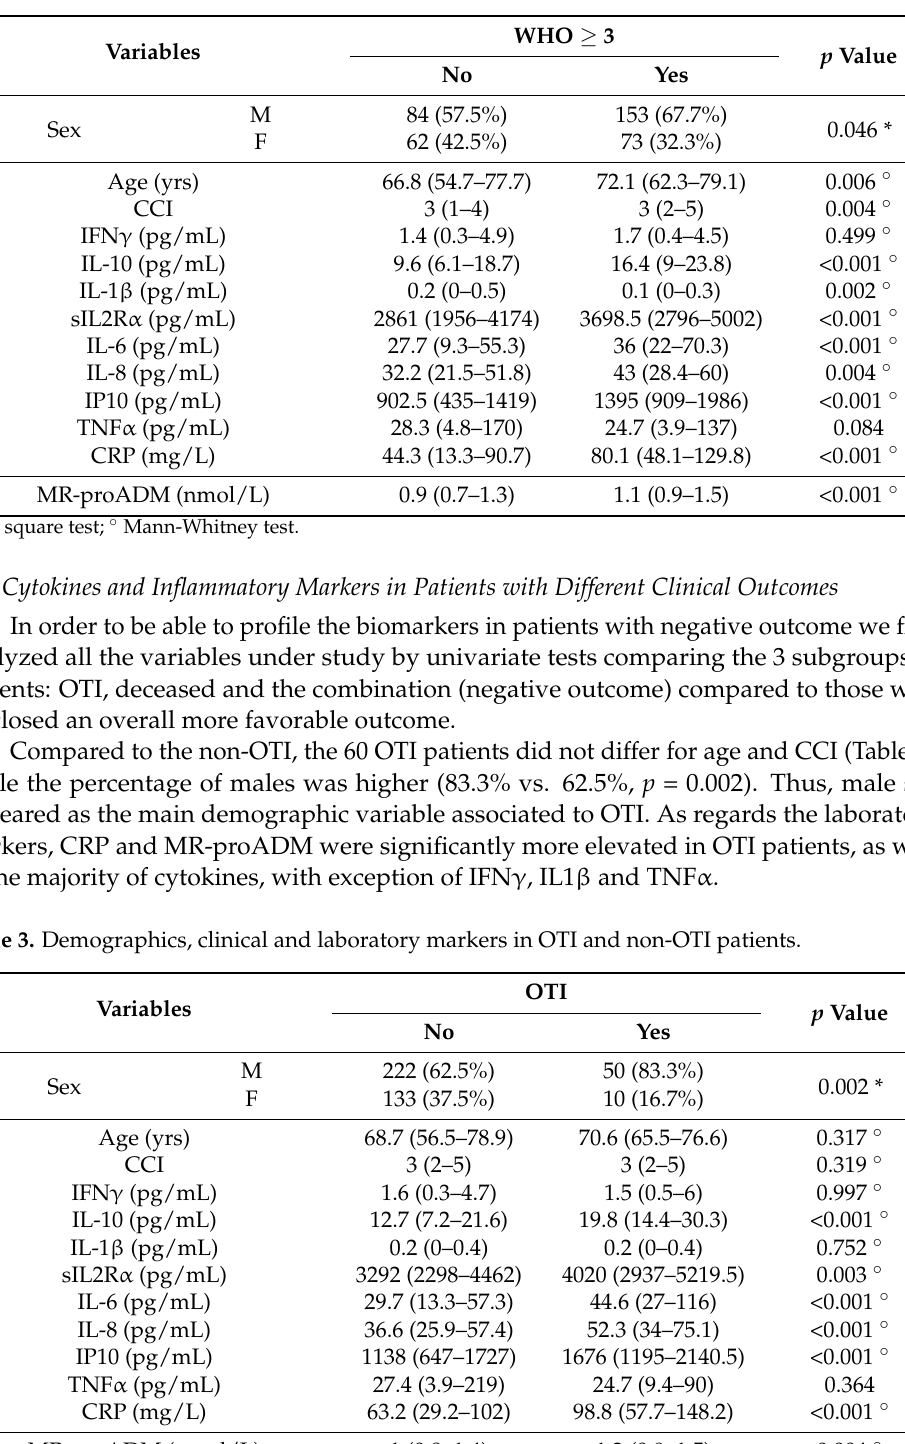
Table 2. Demographics, clinical and laboratory markers in patients with different disease severity. WHO data were available in 372 patients. WHO score goes from 0 to 6 as follows: 0 = asymptomatic; 1 = mild symptoms; 2 = moderate pneumonia symptoms; 3 = severe symptoms of pneumonia without